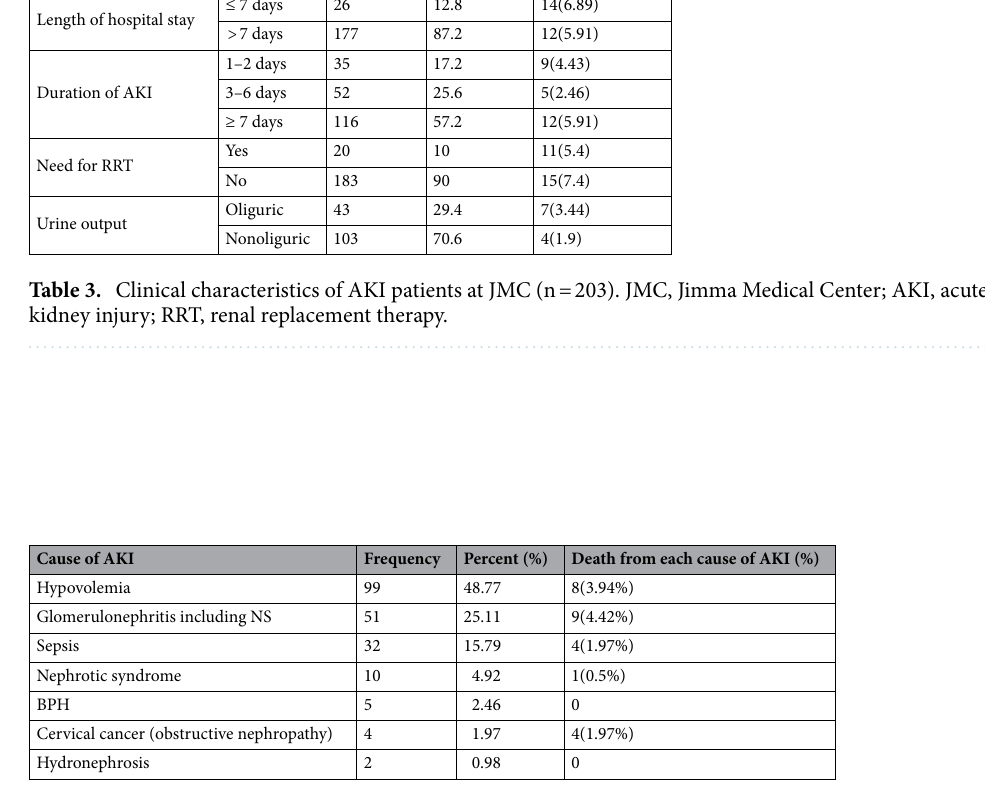
Table 4. Causes of AKI and death from each cause, JMC (n = 203). AKI, acute kidney injury; BPH, benign prostatic hyperplasia; NS, nephritic